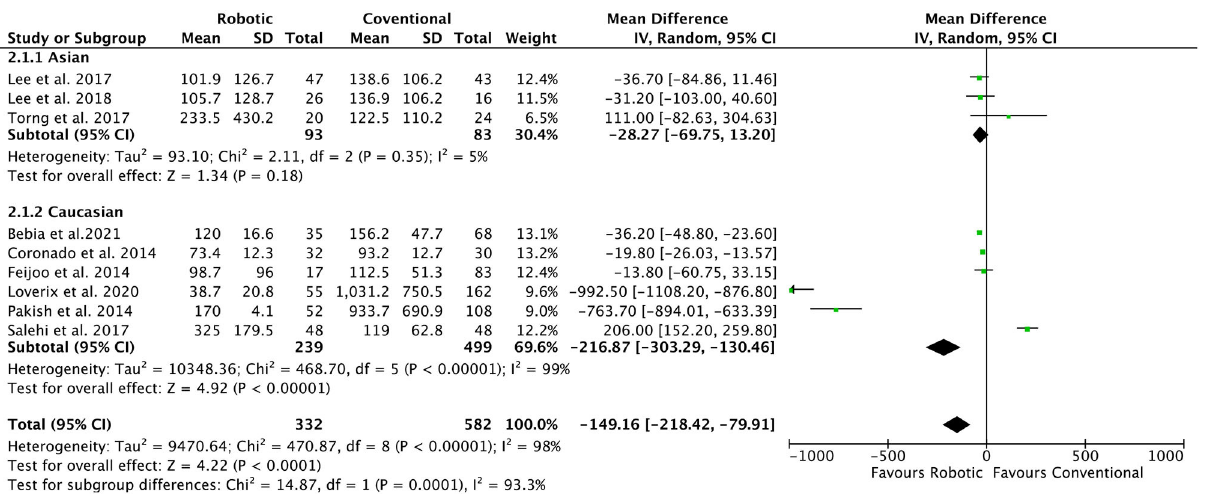
FIGURE 3 | Forest plot of the association of total blood loss (ml) in robotic-assisted vs. conventional laparoscopy for para-aortic lymphadenectomy in gynecological malignancies.